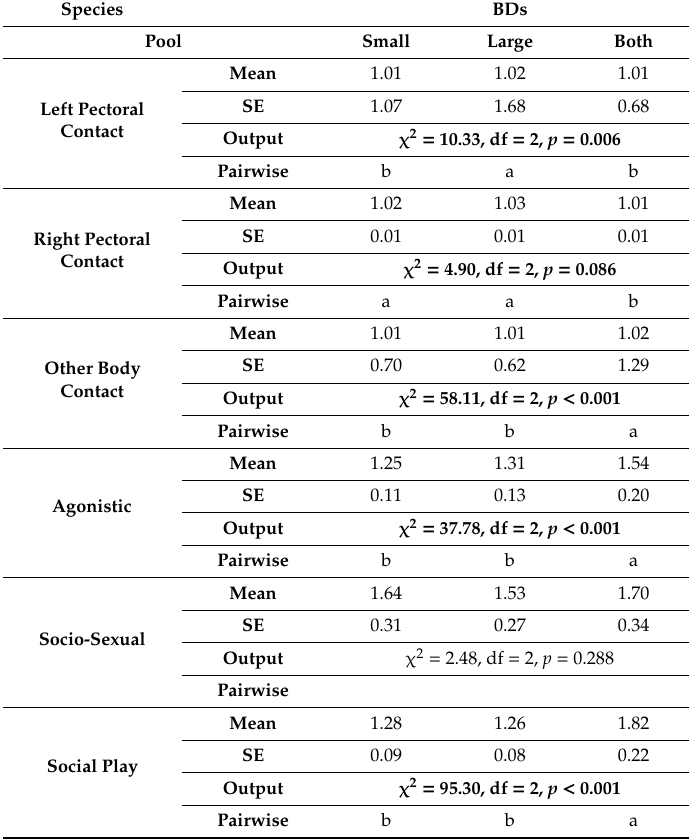
Table 6. Fitted means and standard errors of the frequency of each social behaviour depending on housing pool for bottlenose dolphins (BDs). Outputs come from Wald chi-squared tests run on Generalized linear mixed models, significant outputs are bolded. For each species and each behaviour, items sharing the same letter did not di ff er significantly, items that do not share the same letter di ff er significantly (post-hoc tests with sequential Bonferroni